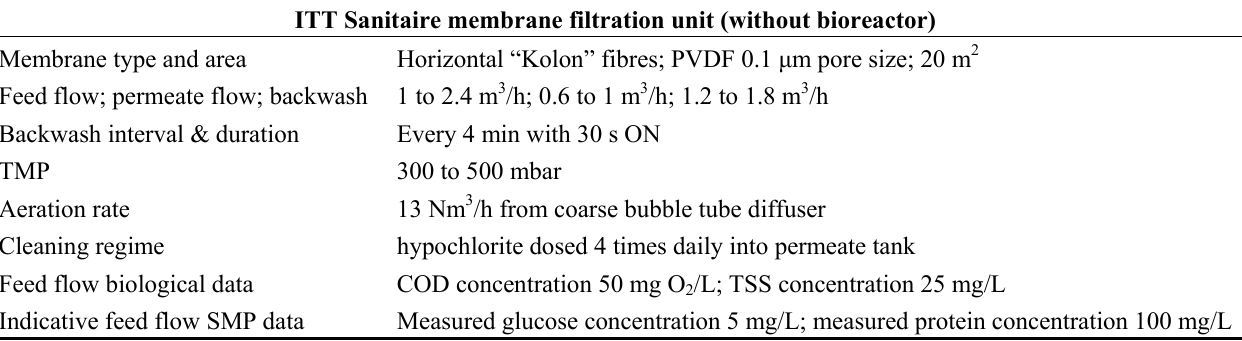
Table 1. Operational data for pilot membrane filtration